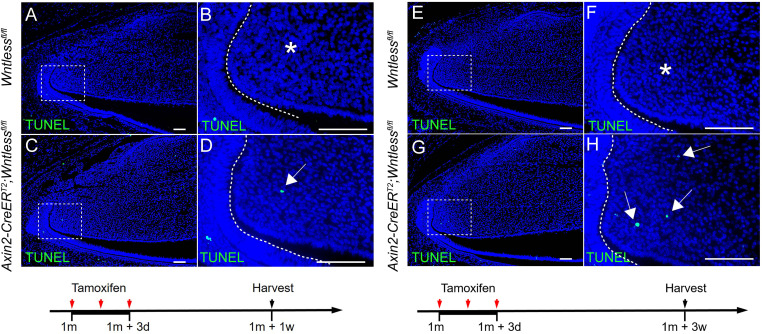
(A-H) TUNEL staining of Wntlessfl/fl and Axin2-CreERT2;Wntlessfl/fl incisors one week and 3 weeks after tamoxifen induction.Arrow indicates positive signal and asterisk indicates absence of signal.